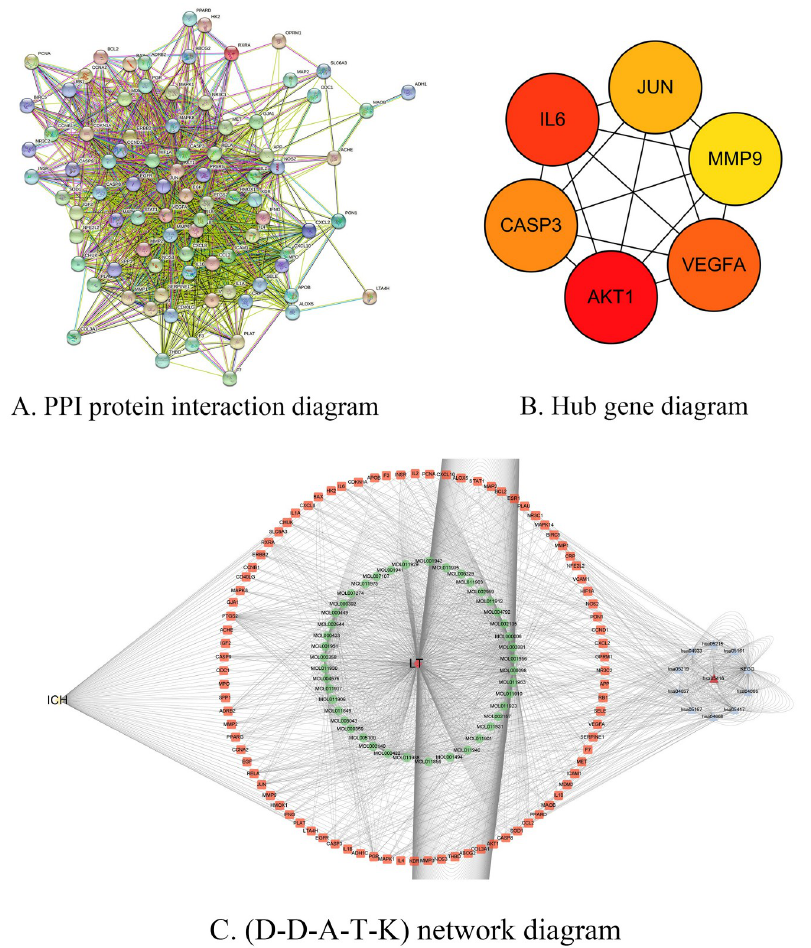
Fig 4. PPI protein interaction map and Hub gene diagram and D-D-A-T-K. Note: A. PPI protein interaction map of 88 intersecting genes. B. Hub gene diagram. C. (D-D-A-T-K) network diagram. ICH for disease, LTG for herb, HSA for KEGG pathway, orange for target, and green for drug active